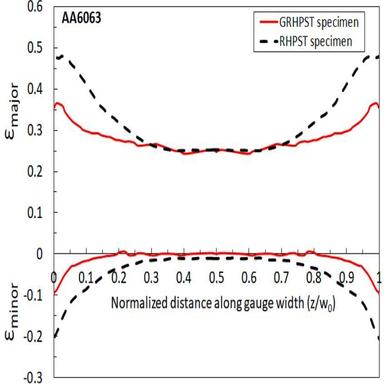
Comparison between the major and minor strains measured using 3D-DIC system across the centerline of the gauge zone for both RHPST and GRHPST samples at 0.3 of major strain (just before occurrence of necking).